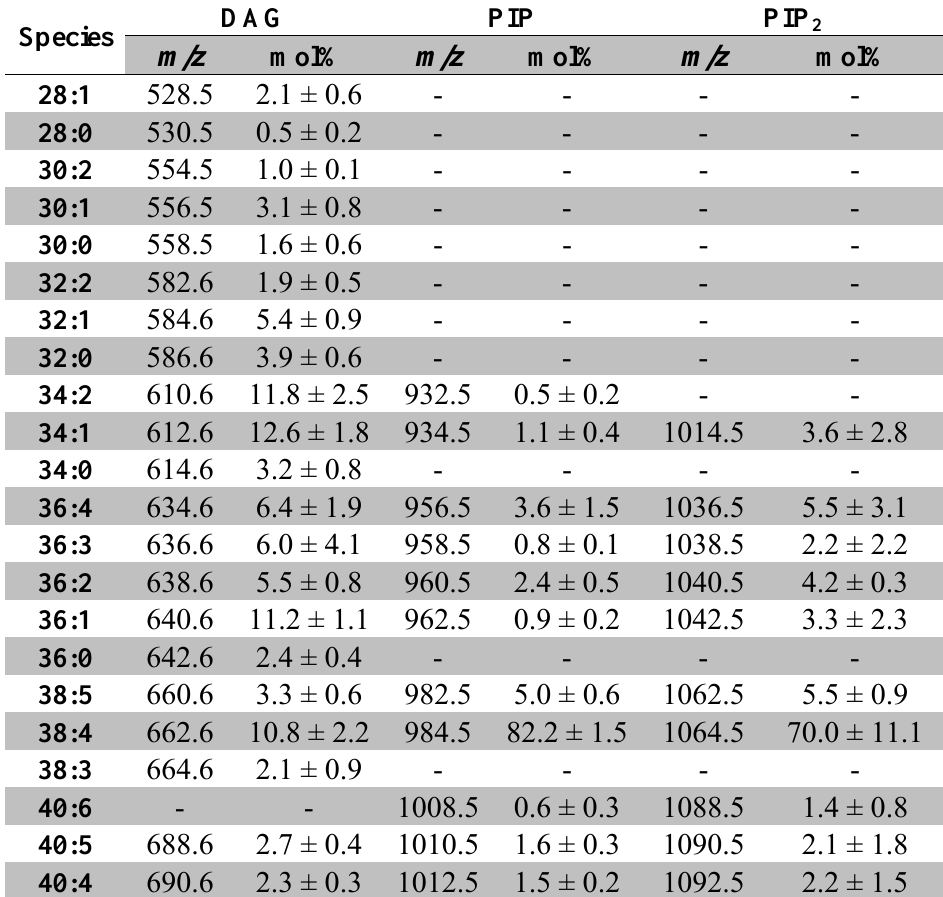
Table 1. DAG, PIP and PIP molecular species identified in lipid extracts of primary 2 human T cells. Identification of DAG species in neutral extracts was done by NL 35 scanning, quantification was done by MPIS. Identification and quantification of PIP and PIP species in acidic extracts was achieved by NL 357 and NL 437 scanning, respectively. 2 m/z values correspond to ammonium adducts (NH 4+ ). Mol% indicates the distribution of lipid species within a given lipid class. Data represent mean values ± SD of three independent